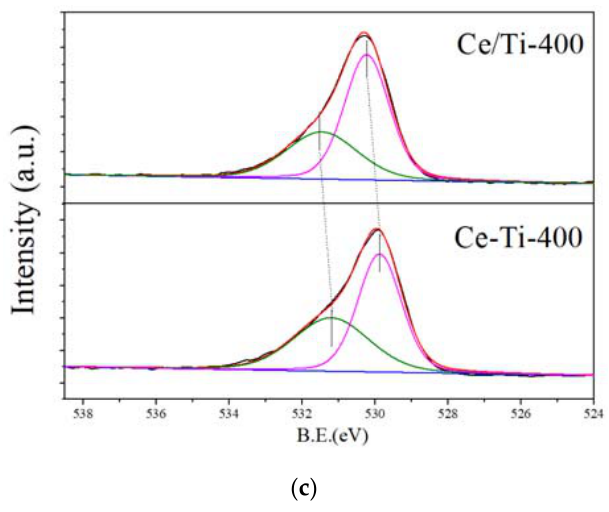
Figure 4. XPS results of Ce 3d ( a ), Ti 2p ( b ) and O 1s ( c ).